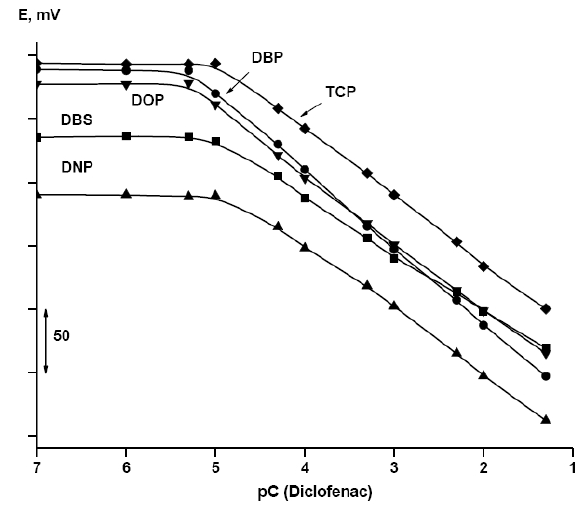
Fig. 2 Effect of the nature of plasticizers on the response of the proposed electrode (the membranes No ¯1, 3 - 6 were used; pH 6.5) at different DCF − concentrations.